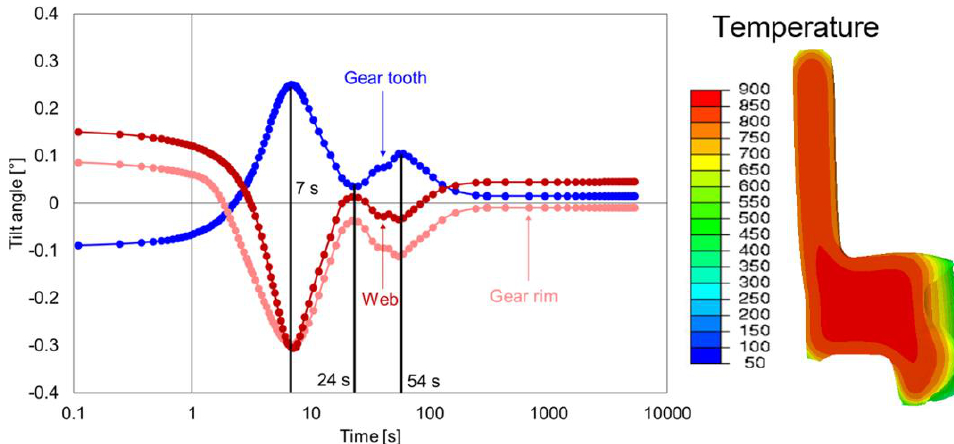
Figure 14. Tilt angle development of the web, gear rim, and gear tooth for the geometry type G1 ( left ), and a contour plot with temperature distribution at 2 s ( right ).